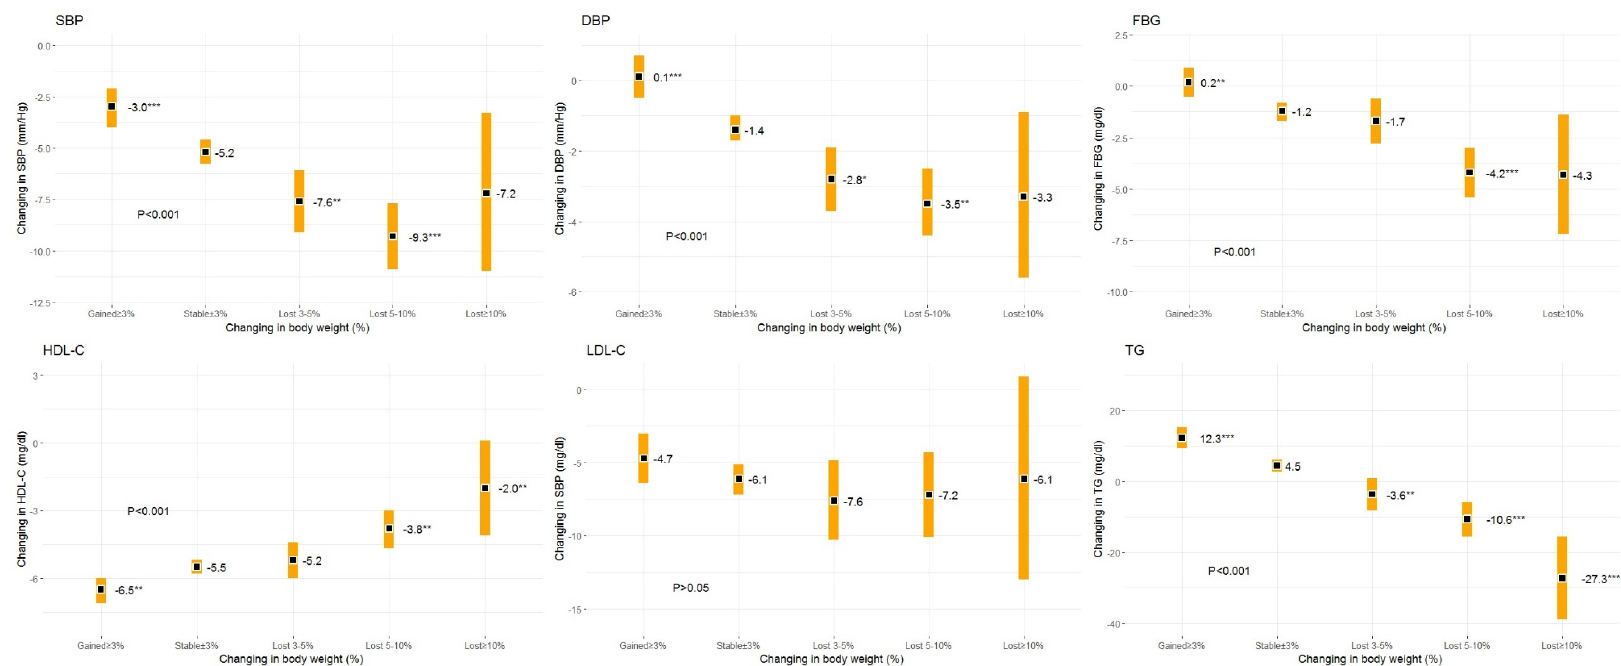
Figure 2. Changes in CVD risk factors by weight loss categories. Notes: Data are presented as the least square means with 95% Cis. Adjustment pertains to age, gender, baseline level of the outcome variables, and baseline weight. Abbreviations: SBP, systolic blood pressure; DBP, diastolic blood pressure; FBG, fasting blood glucose; HDL-C, high-density lipoprotein cholesterol; LDL-C, low-density lipoprotein cholesterol; TG, triglyceride. * p < 0.05; ** p < 0.01; *** p < 0.001 vs. stable category.